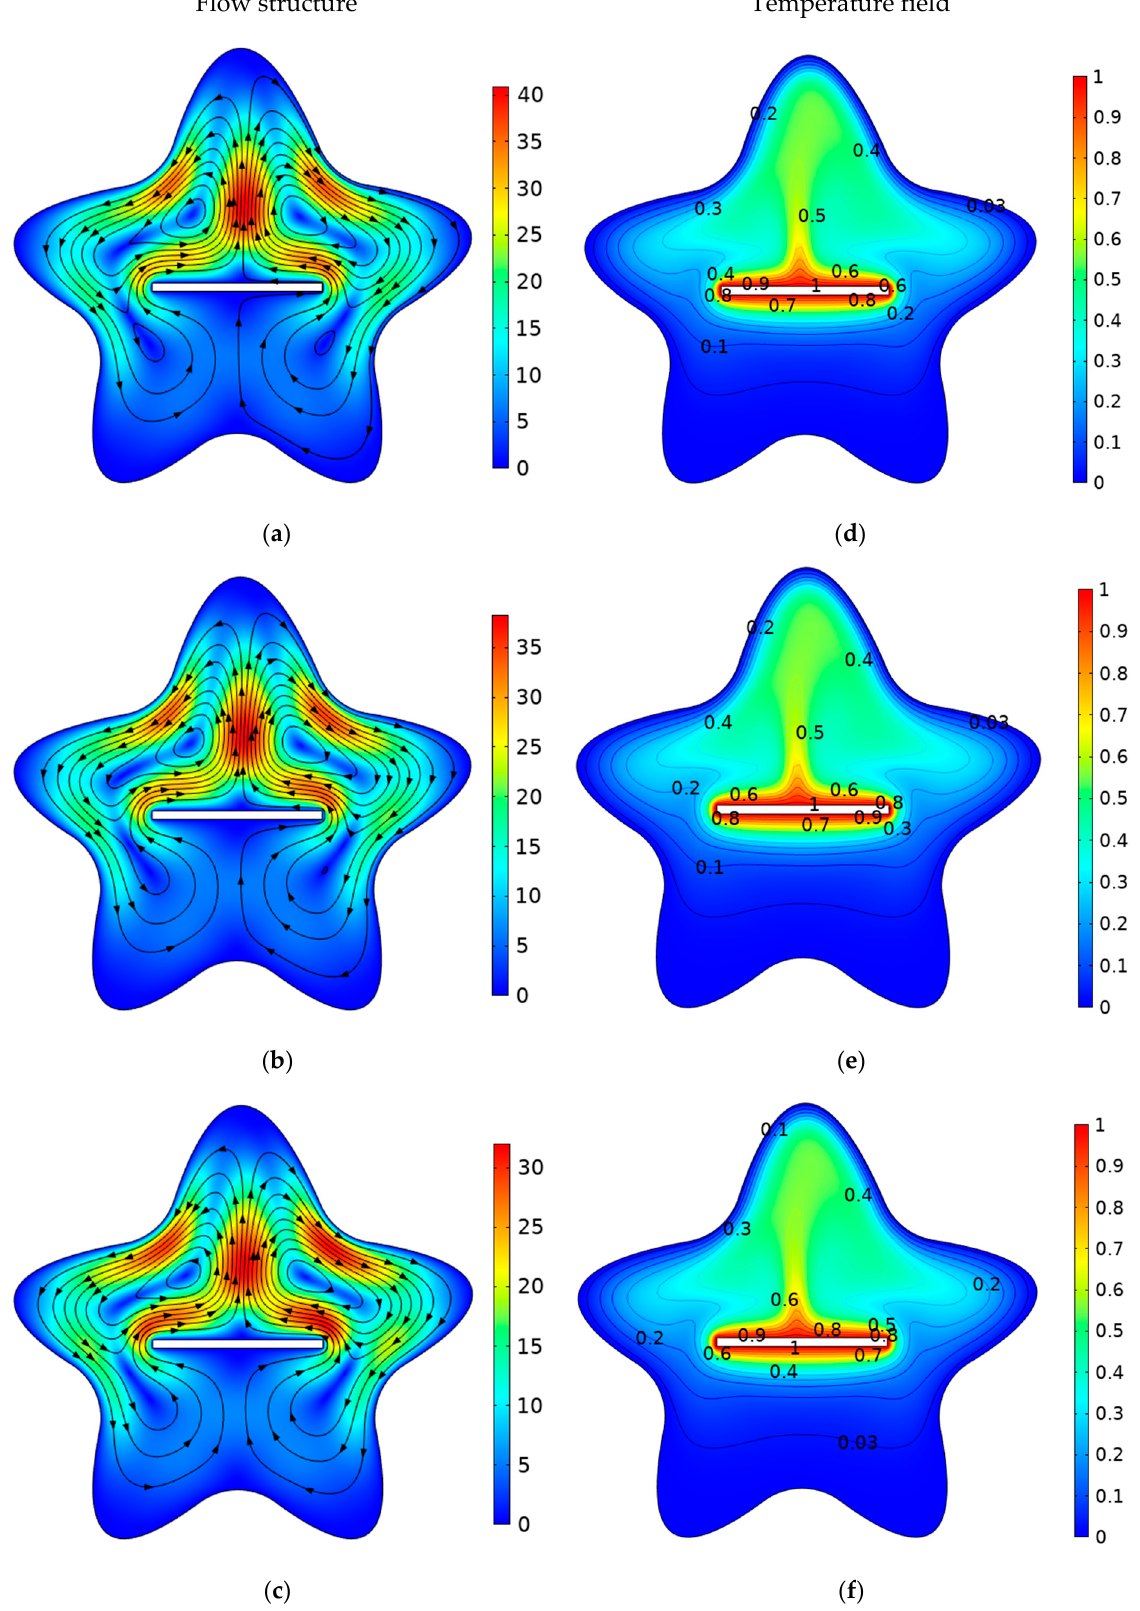
Figure 5. Flow structures ( a – c ) and temperature fields ( d – f ) for Ra = 10 5 , φ = 0.04, and various Hartman number ( Ha ) values. ( a ) Ha = 0; ( b ) Ha = 40; ( c ) Ha = 80; ( d ) Ha = 0; ( e ) Ha = 40; ( f ) Ha = 80.